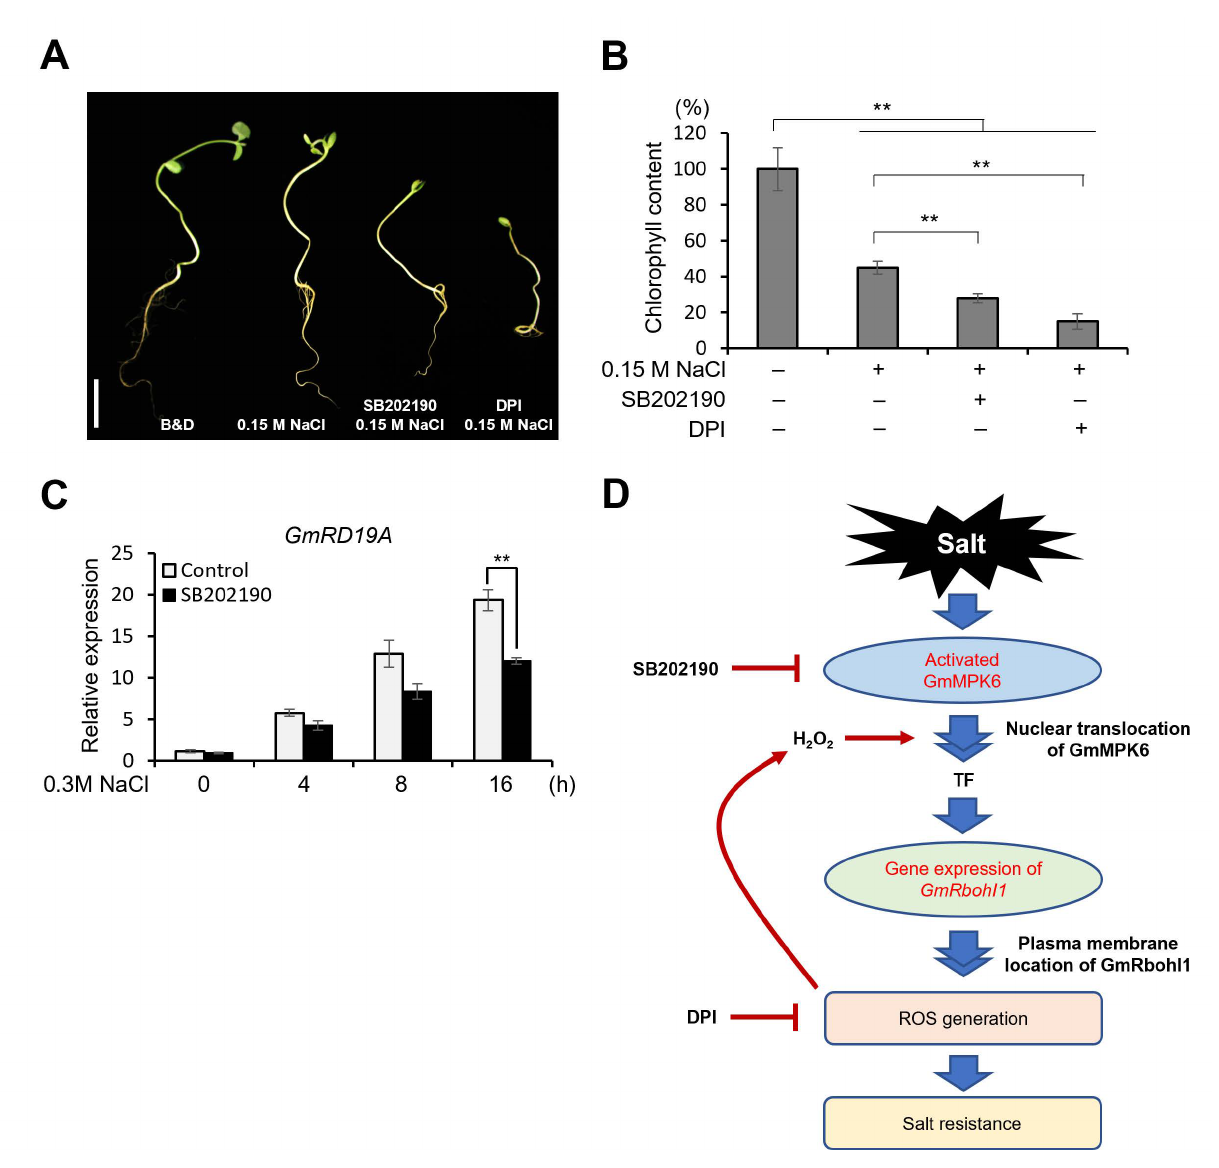
Figure 2. GmMPK6 increases salt tolerance. ( A ) The phenotype of NaCl with MPK inhibitor or NADPH-oxidase inhibitor-treated soybean seedling. Four-day-old seedlings were treated with 0.15 M NaCl and with or without 30 µ M SB202190 or 50 µ M DPI for 3 days. B & D solution-treated soybean seedlings were used as a control. Bar = 2 cm. ( B ) The chlorophyll contents of 0.15 M NaCl and inhibitors, respectively, co-treated soybean leaves. Ten-day-old soybean seedlings were treated with 0.15 M NaCl, 30 µ M SB202190 + 0.15 M NaCl, and 50 µ M DPI + 0.15 M NaCl for 5 days, respectively, and then chlorophyll contents were measured for leaves. B & D-solution-treated soybean seedlings were used as a control. ( C ) The effect of SB202190 on the expression of GmRD19A in NaCl-treated soybean seedlings. Seven-day-old seedlings were treated with 30 µ M SB202190 for 1 h, followed by the treatment of 0.3 M NaCl for designated time points. For RT-qPCR, total RNA was isolated, and the amplification was carried out with gene-specific primers (Table S1). ( D ) Schematic diagram of GmMPK6-dependent ROS generation through the induction of GmRbohI1 . Data are means ± SD of three repeats: **, p <